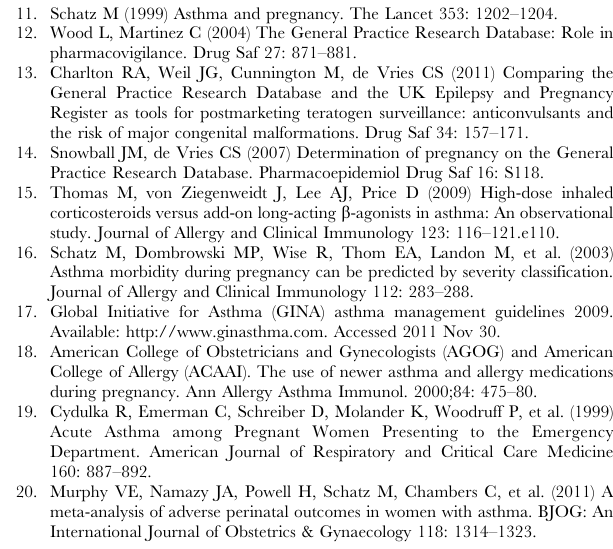
Table S1 Number and percentage of deliveries where the